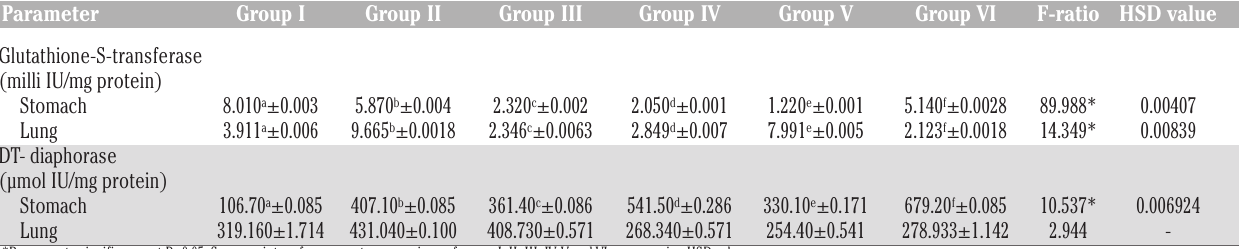
Table 3. Modulation of DMBA induced impairment of detoxification enzymes by betulinic acid among different treatment groups of female Sprague Dawley rats.